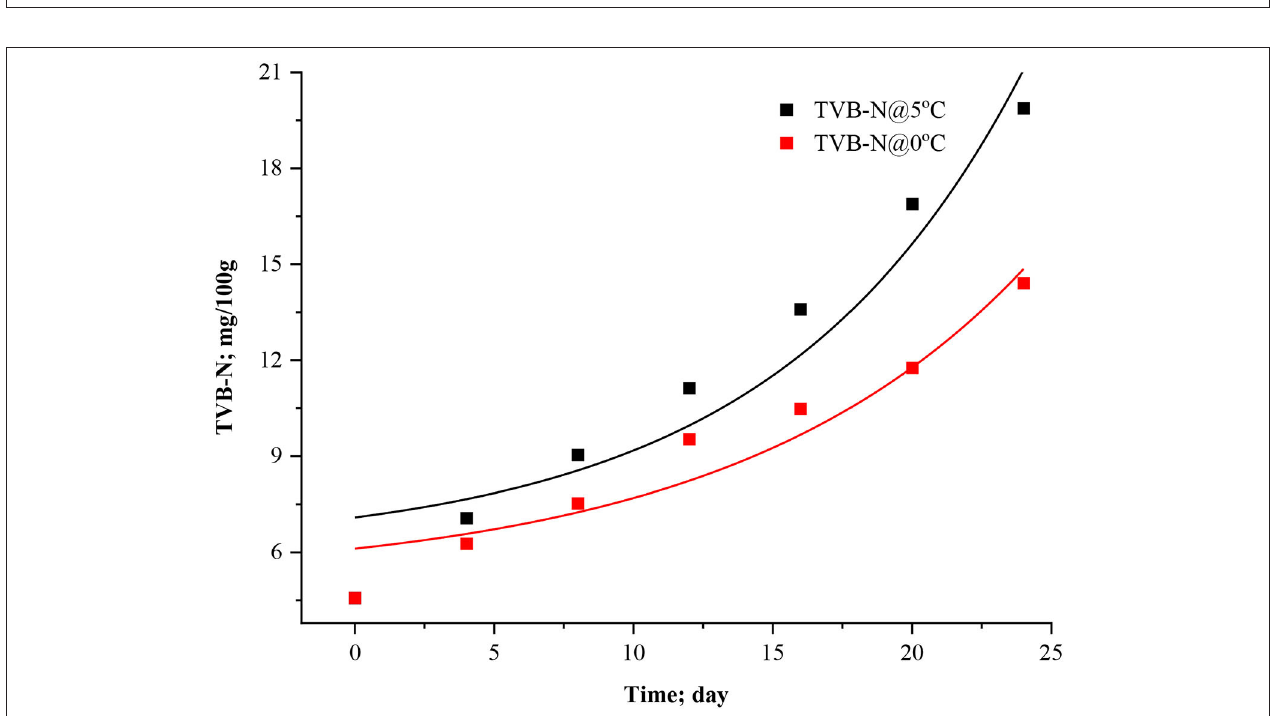
FIGURE 2 | Modified exponential model curve for TVB-N in stored Rohu fish.